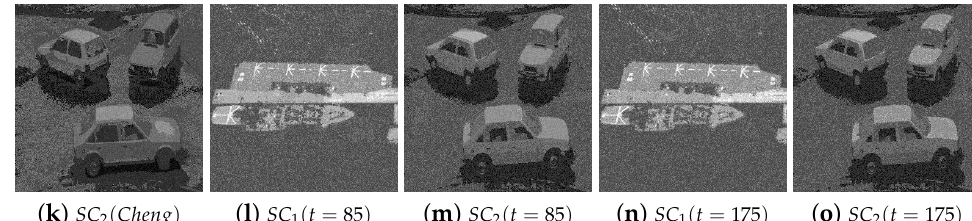
Figure 4. ( 2,2 ) threshold experimental results with relative methods; ( a ) grayscale secret image; ( b – e ) grayscale and binary cover images; ( f , g ) meaningful shadows in Yan’s scheme; ( h , i ) meaningful shadows in Liu’s scheme; ( j , k ) meaningful shadows in Cheng’s scheme; ( l – o ) meaningful shadows in the proposed scheme with t = 85 and t = 175.